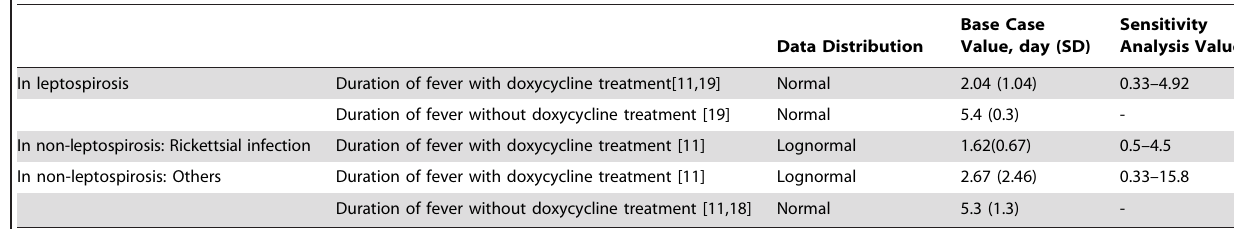
Table 3. Outcome of treatment.